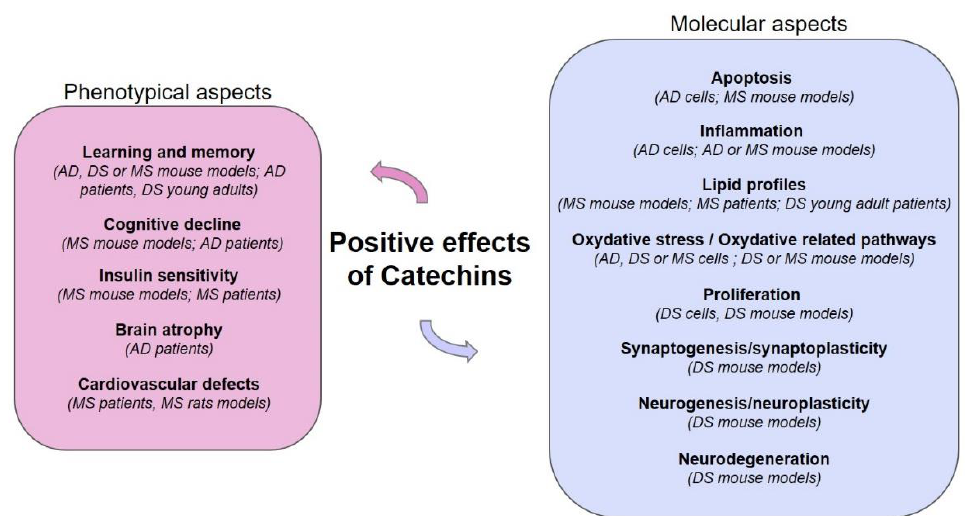
Figure 2. Major positive effects of catechins on several aspects of Down syndrome (DS) and its main comorbidities, Alzheimer’s disease (AD) and metabolic syndrome (MS).